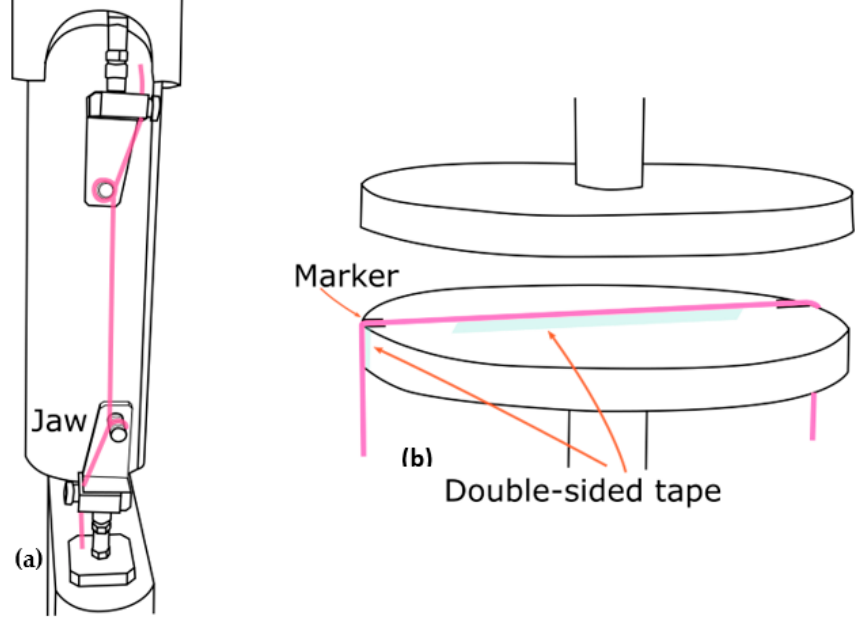
Figure 2. Setting of ( a ) tensile test and ( b ) compression test of the tubular samples.